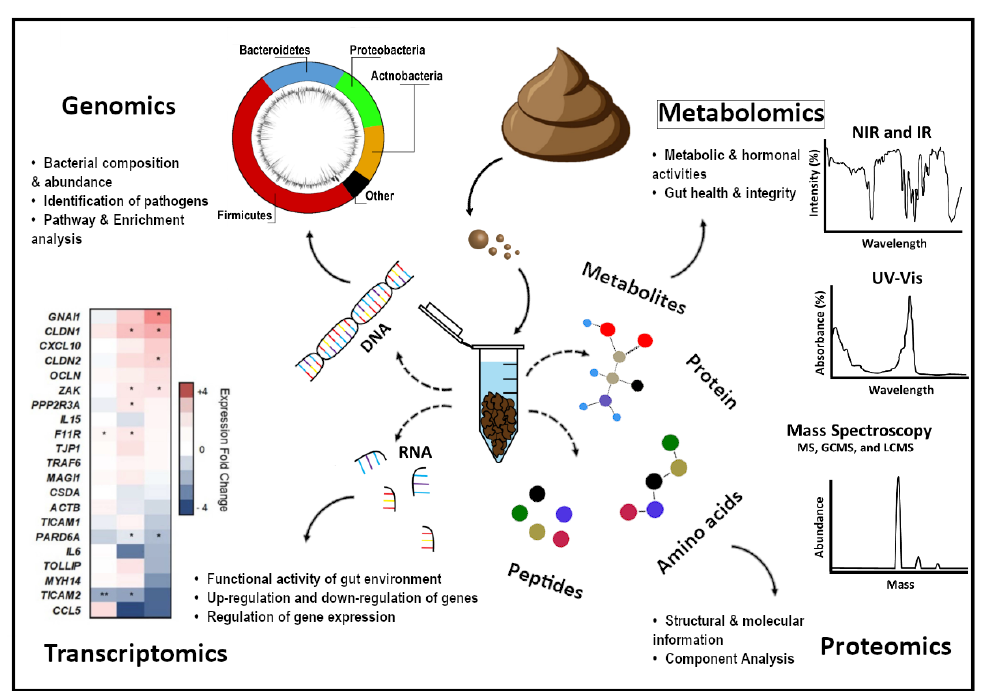
Figure 1. Schematic diagram of information that can be extracted from a fecal sample.